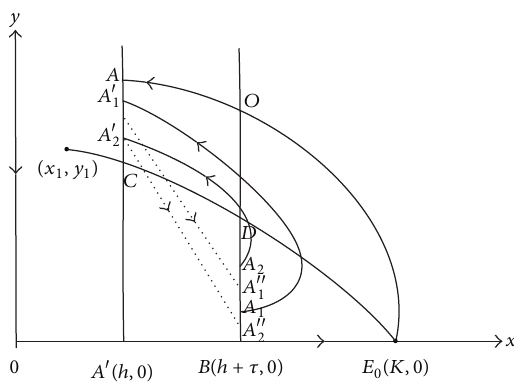
𝐴 is mapped to the point 𝐷 after impulsive effect, that is to say, (1 − 𝛽 0 )𝑦 𝐴 = 𝑦 𝐷 .